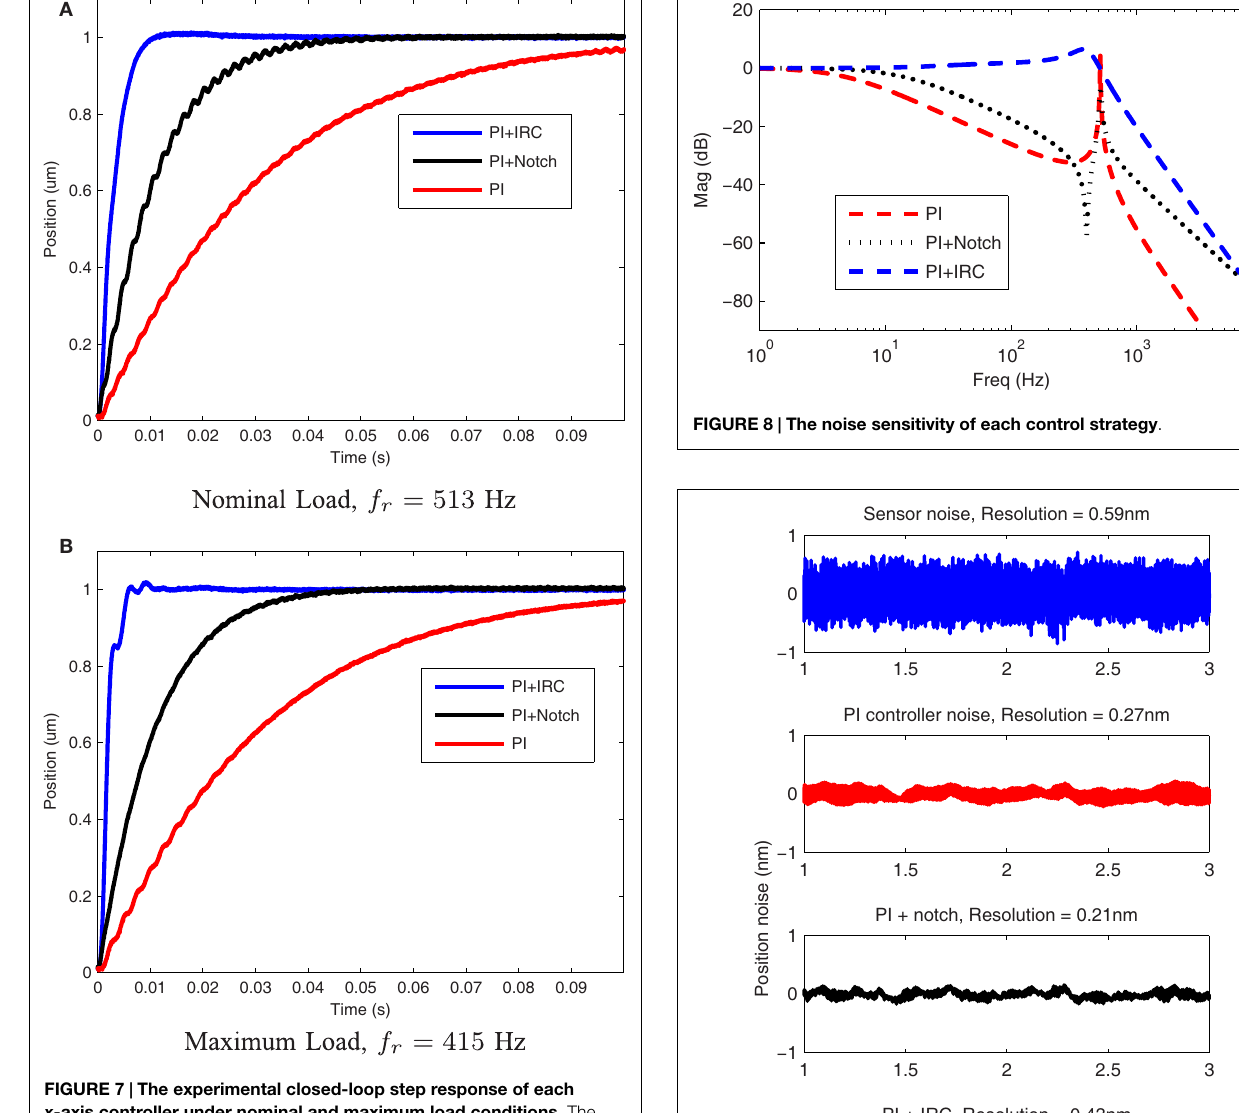
the tracking loop. This is a drawback since the noise bandwidth cannot be reduced by varying the tracking controller gain. Figure 8 . Due to the wide bandwidth of the damping controller, the noise sensitivity bandwidth is significantly greater than the PI and inverse controllers.